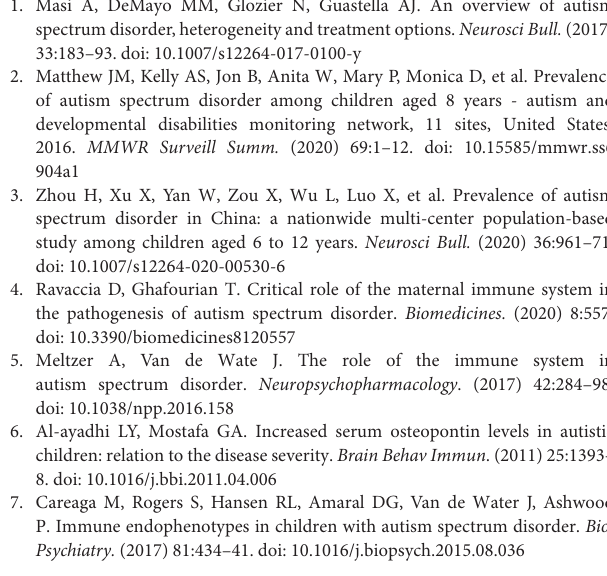
Supplementary Figure 3 | The QC analysis of the proteome. (A) within-group coefficient of variation; (B) Principal Component Analysis (PCA). Supplementary Table 1 | The significantly enriched terms in the biological process. Supplementary Table 2 | The top 10 different metabolites in positive ion mode. Supplementary Table 3 | The top 10 different metabolites in negative ion